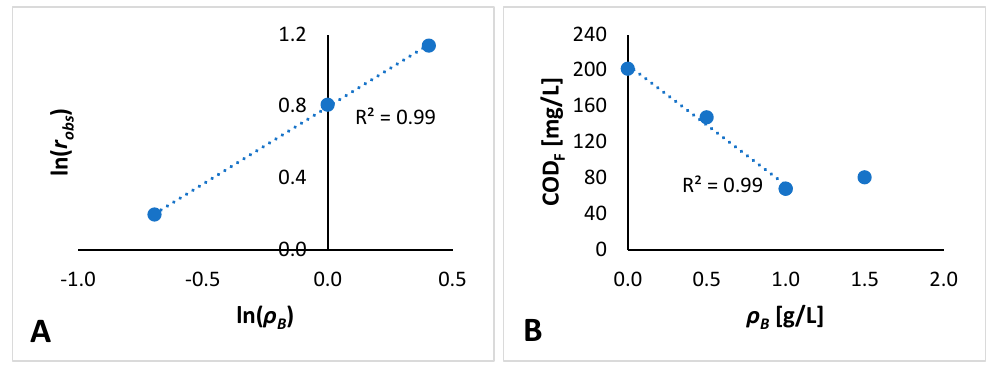
Figure 5. Effect of the catalyst loading on ( A ) the observed reaction rate, r obs , and ( B ) the COD plateau value, COD F .